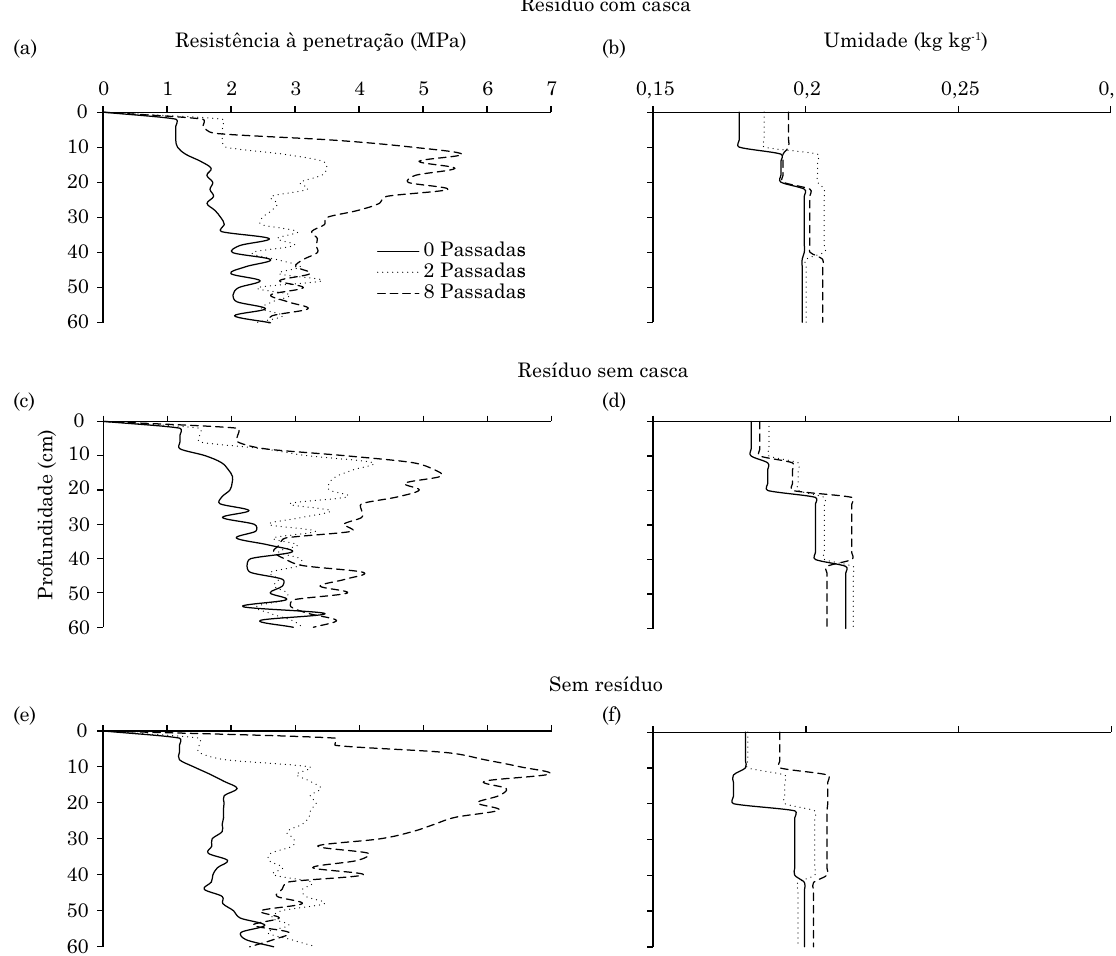
Figura 4. resistência à penetração (a, b, c) e umidade do solo (d, e, f), de acordo com o número de passadas do forwarder sobre resíduo da colheita do eucalipto sem casca (sc); resíduo com casca (cc); e solo sem resíduo (sr) de um latossolo amarelo em belo oriente, Mg, aos 5,88 anos de idade do